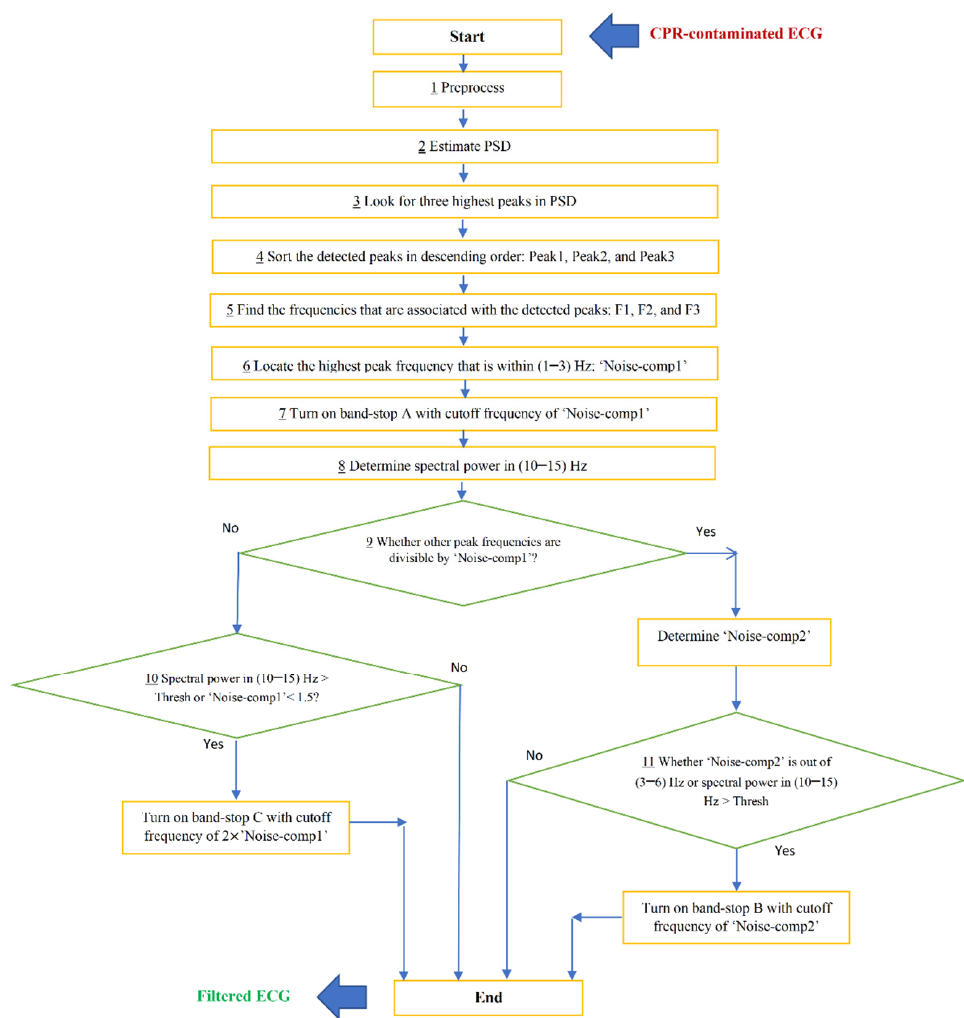
Figure 4. Block diagram of the proposed filtering algorithm.